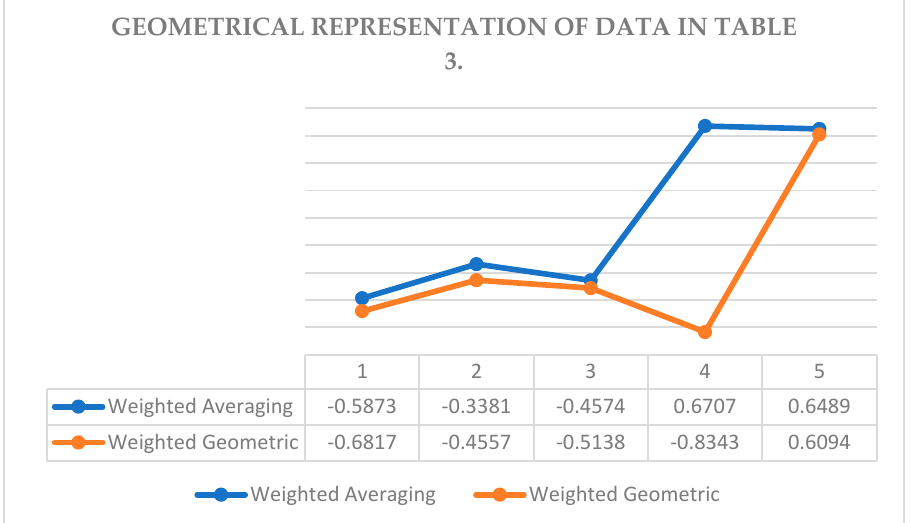
Figure 1. The score values are represented geometrically. Where blue lines show the score values of WA while orange lines show the score value of WG aggregation. Table 5. Ranking of the score